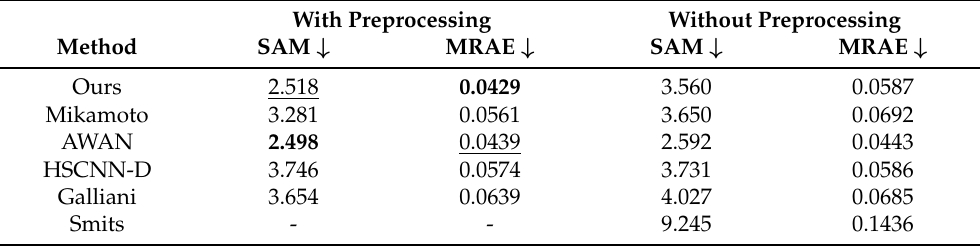
Table 4. The results when LDR-RGB images are input to the networks trained with HDR images. Bolded and underlined indicate the best and second-best results,